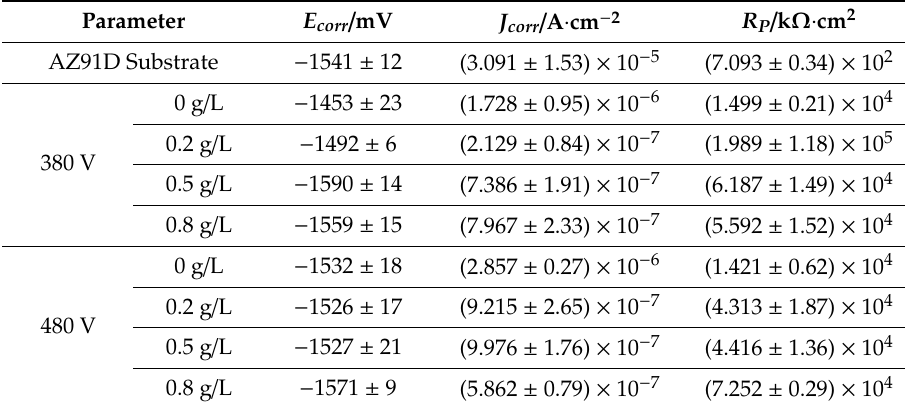
Table 3. Derived results from polarization curves shown in Figure 9.